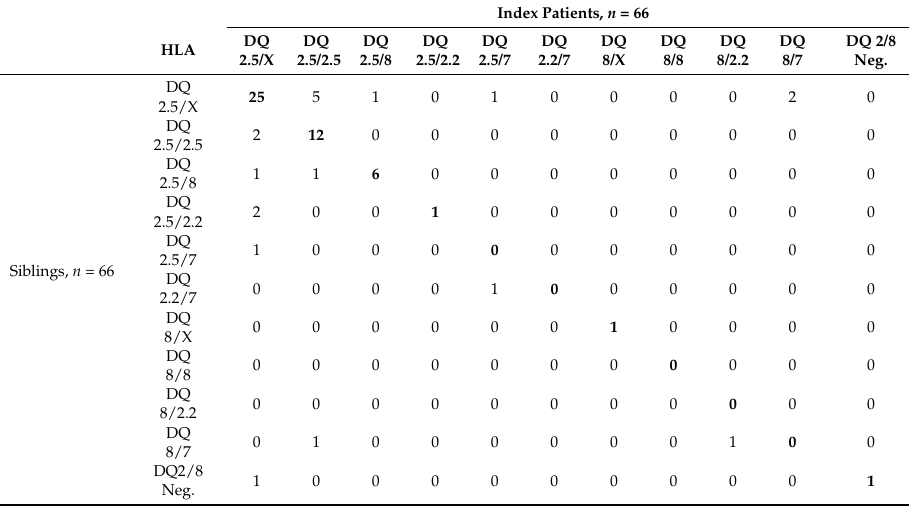
Table 4. Concordance of human leukocyte antigen (HLA) haplotypes in 66 sibling pairs. Results are presented as numbers of sibling pairs. Pairs with similar genotype bolded. DQX = other than DQ2.5, DQ2.2, DQ7, or